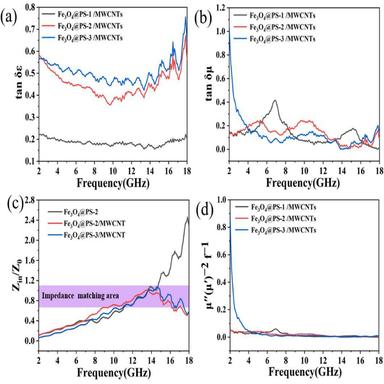
Dielectric loss tan δε (a) and magnetic loss tan δμ (b) of Fe3O4@PS/MWCNT samples. (c) Impedance matching index of samples. (d) C0 values of Fe3O4@PS/ MWCNT samples.